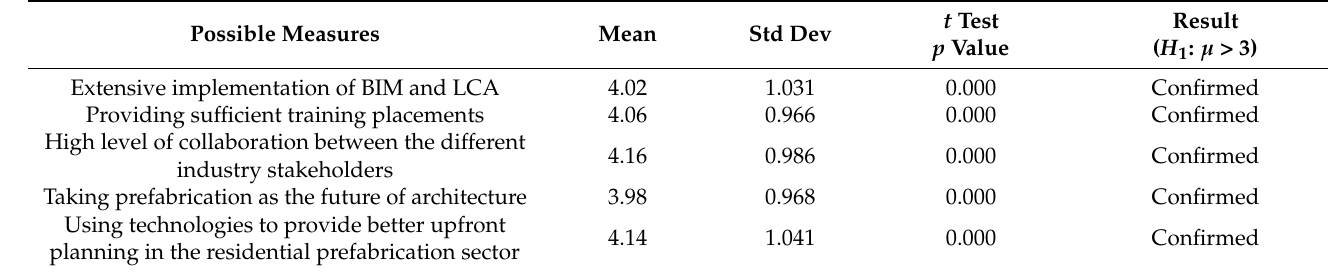
Table 4. Mean comparison of possible measures to increase prefabrication